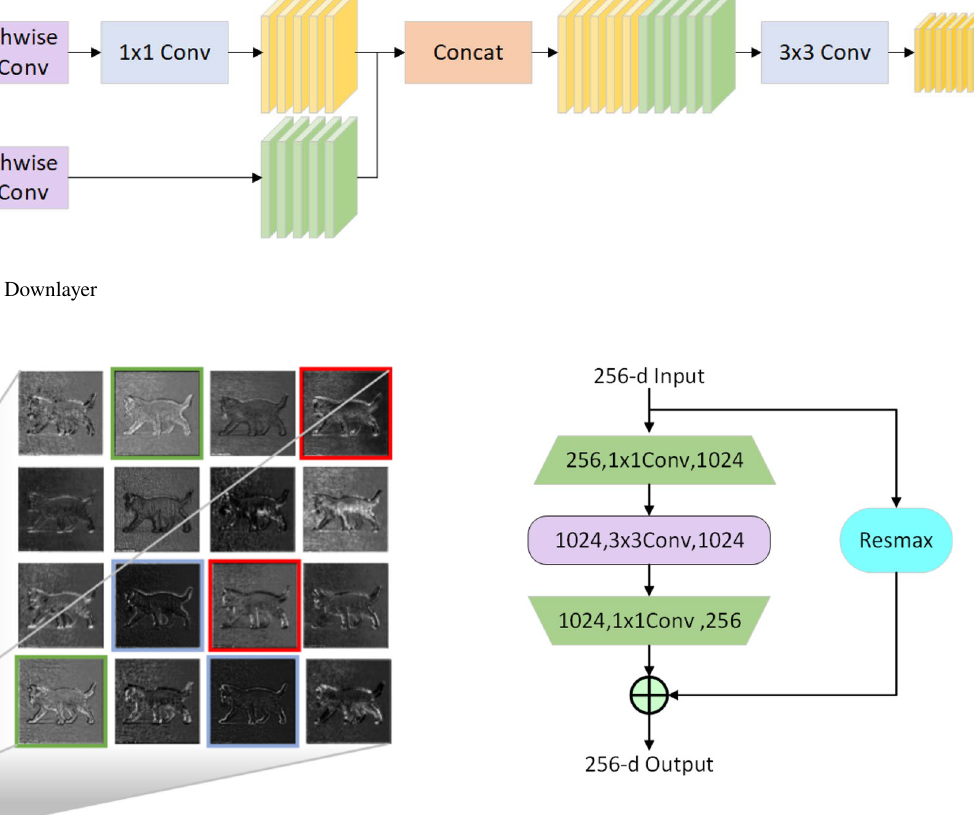
Fig. 5 The structure of Extraction